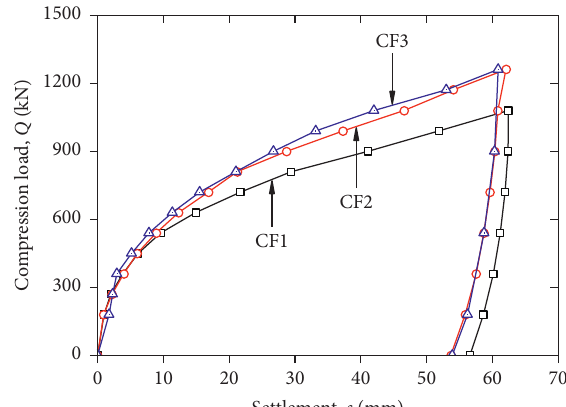
Figure 5: Variation of applied compression load against pier-head settlement.